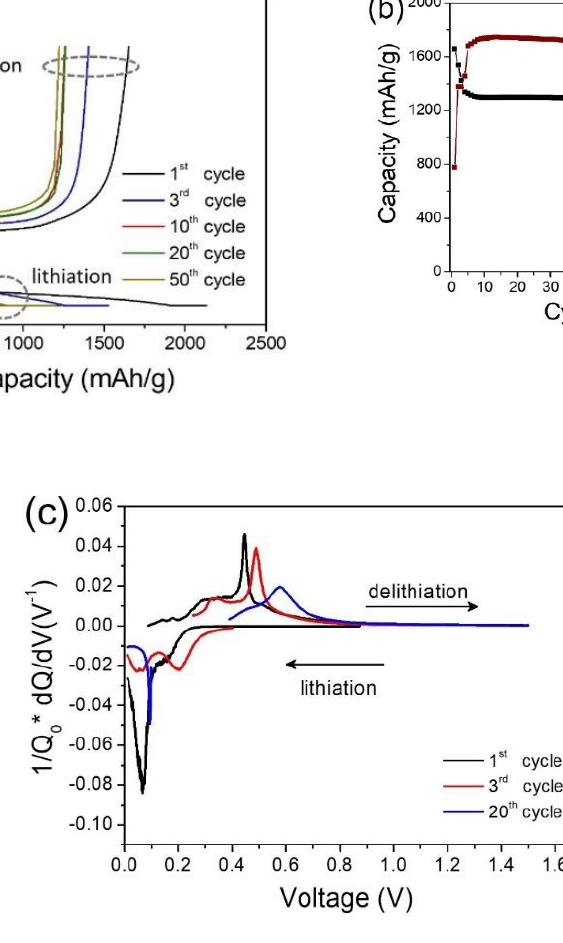
Figure 3. Electrochemical characteristics of the coin-type half cells produced by 8 h milled Si/C nanocomposite powders: ( a ) potential vs. lithiation/delithiation curves; ( b ) discharge capacity and coulombic efficiency; and ( c ) differential capacity plot for 1st, 3rd, and 20th cycle.